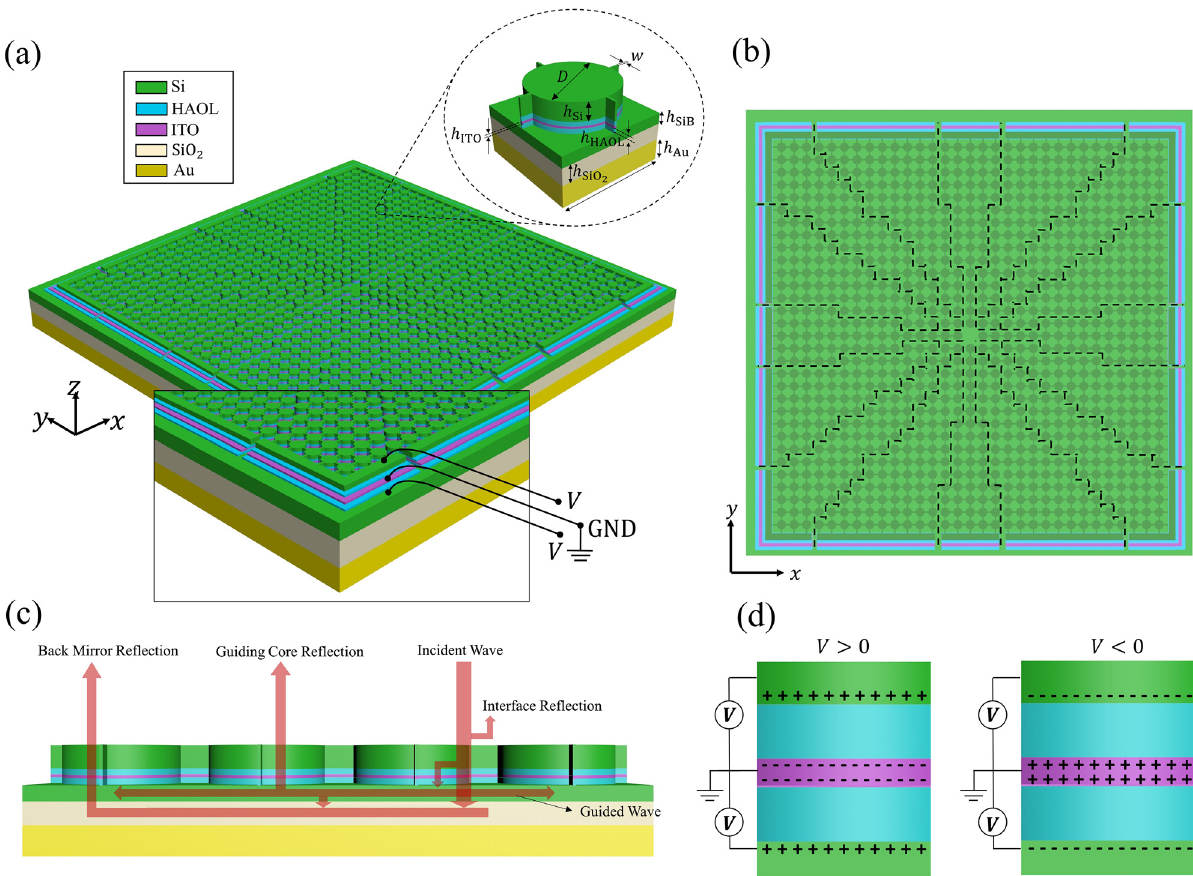
Figure 3: (a) The schematic depiction of the proposed metasurface consisting of an array of subwavelength Si/HAOL/ITO/HAOL nanodisk heterostructures placed on top of a silicon guiding core followed by a silica buffer and a gold back mirror rendering a fi eld-effect tunable GMRM. The metasurface is azimuthally divided into 16 equal sections wherein nanodisks are interconnected via nanobar heterostructures serving as biasing lines, while adjacent sections are isolated via termination in the biasing lines. The geometrical parameters of the unit cell shown in the zoomed-in view are chosen as D (cid:2) 581 nm, h Si (cid:2) 362 nm, h HAOL (cid:2) 28 nm, h ITO (cid:2) 9 nm, h SiB (cid:2) 171 nm, h OB (cid:2) 450 nm, w (cid:2) 10 nm and Λ (cid:2) 613 nm.ThemetasurfaceisunderilluminationofanormallyincidentTEpolarizedwave. (b) Thetop-viewofthemetasurfacewherethe boundaries between the azimuthal sections are denoted by the dashed lines. (c) Demonstration of the wave coupling and light interaction mechanisms in the GMRM. Multiple optical paths in re fl ection and particularly the elongated path through in-plane propagation of guided waves yield enhanced tunability of the optical response through enhanced light – matter interaction with the active regions formed within ITO layer under applied bias voltage. (d) Formation of charge accumulation/depletion layers at the top and bottom interfaces of ITO-HAOL and Si- HAOL under fi eld effect in the dual-gate biasing